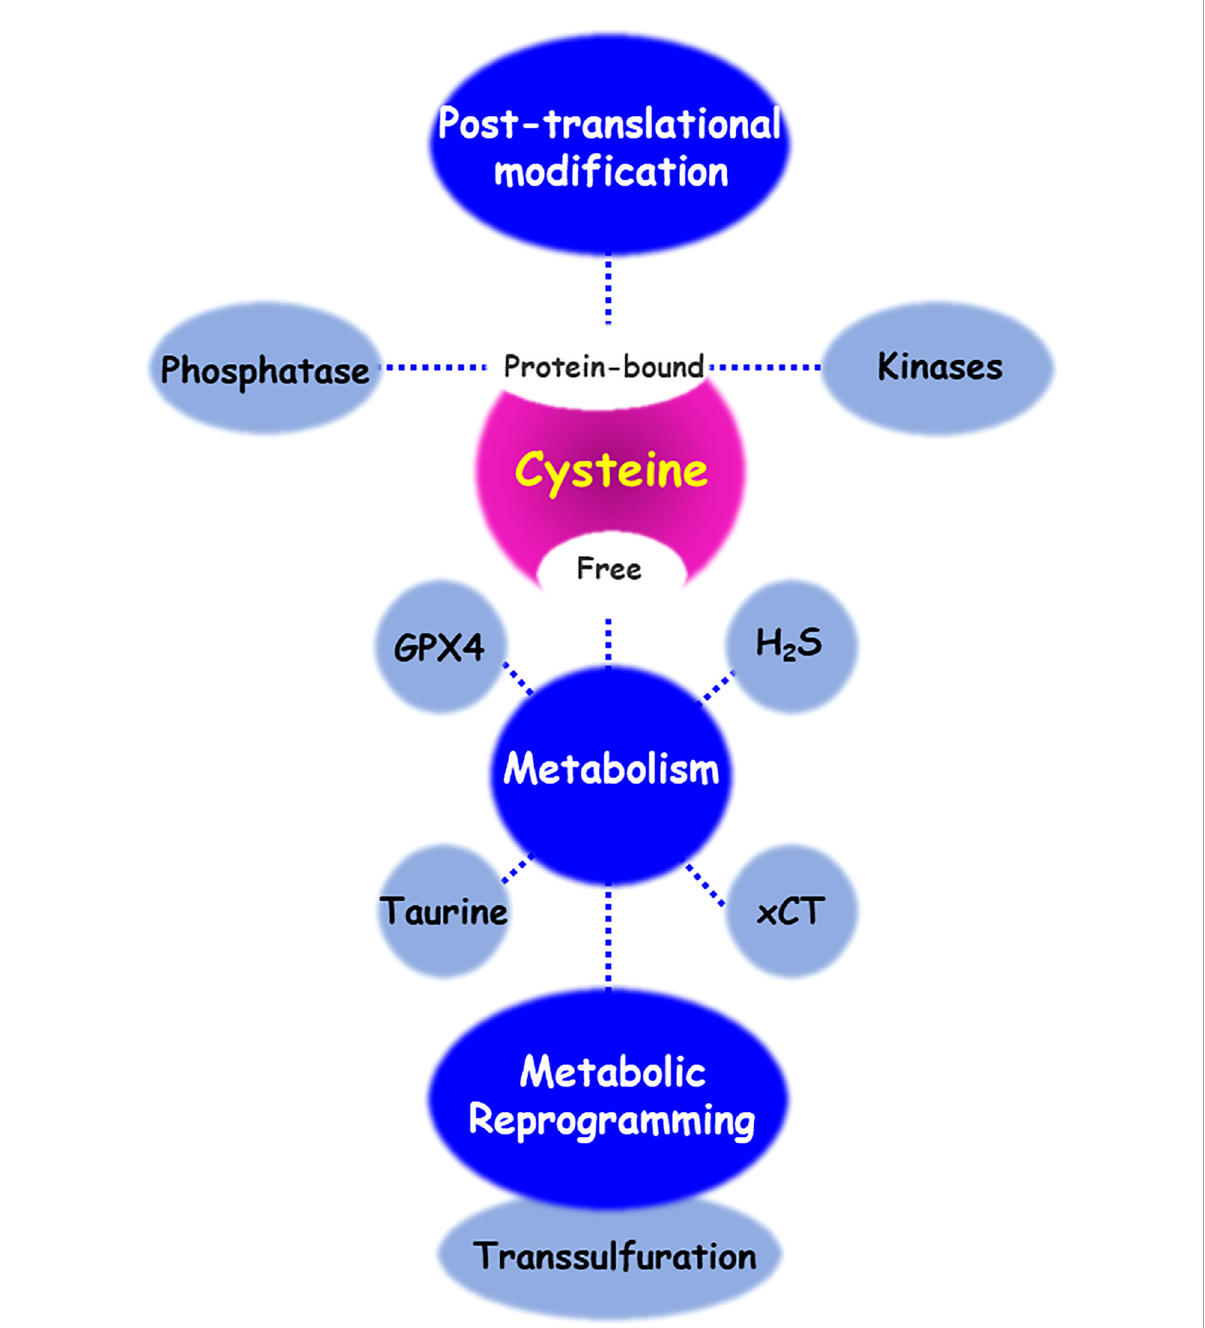
FIGURE 4 Cysteine metabolic fate. There are diverse regulatory mechanisms of cysteine bound to or free from proteins. Enzymes and metabolites of cysteine transport and metabolism enables cancer cells to contributing cancer progression and acquiring chemoresistance. In addition, cysteine residue of proteins undergoes various post-translational modi fi cations, to maintain its redox homeostasis. Oxidative stress and small molecule inhibitors-induced cysteine modi fi cations regulate the function of both protein phosphatases and